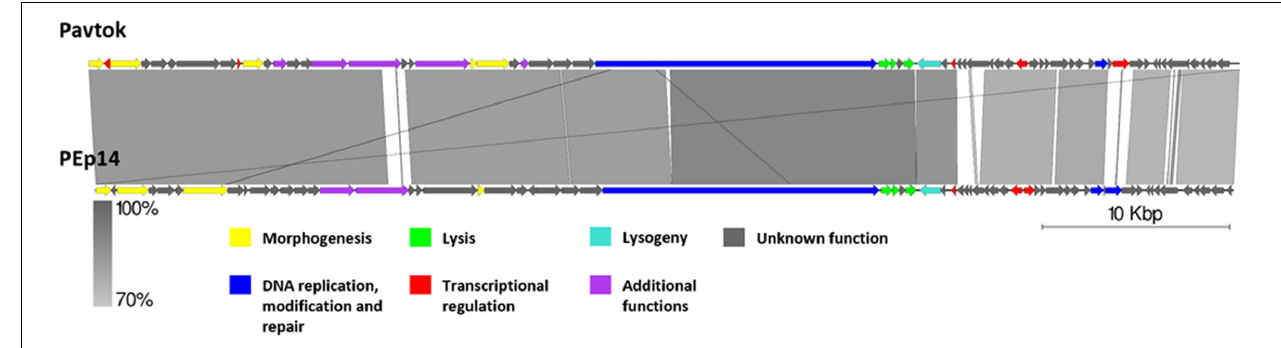
FIGURE 5 | Pairwise genome nucleotide sequence comparison of phages from the suggested cluster 1. Genomes are linearized and drawn to scale; the scale bar indicates 10 thousand base pairs. Arrows representing open reading frames point in the direction of transcription and are color-coded according to the legend. Gray boxes between genomes represent regions of similarity and are gradient-colored according to their identity; darker shade of gray represents higher identity.